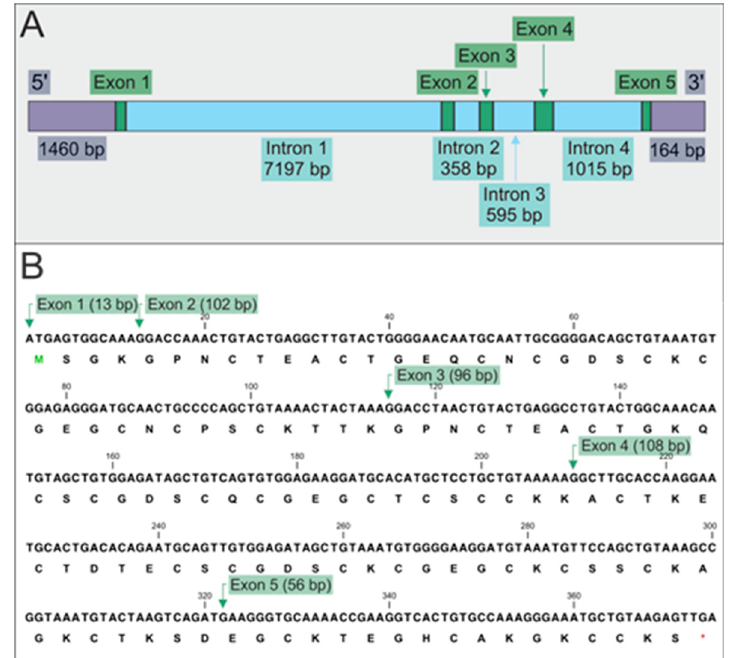
Figure 1. Structural organization of the Metallothionein ( MT ) gene from Biomphalaria glabrata . ( A ) Map showing the exon/intron structure of the gene. Positions and length of exons (green), introns (blue), the promoter at the 5 ′ end-and the 3 ′ -untranslated region (UTR) (lilac) are specified by boxes above and underneath the gene map; ( B ) linked exons 1–5 (shaded in green) with starting points (green arrows) and length (in parentheses), coding for amino acid sequence of the MT protein (shown in one-letter amino acid code below base triplets).